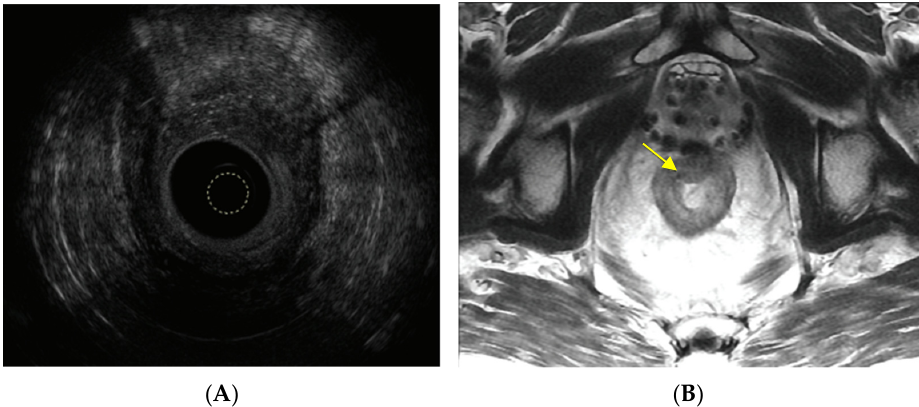
remains unknown.